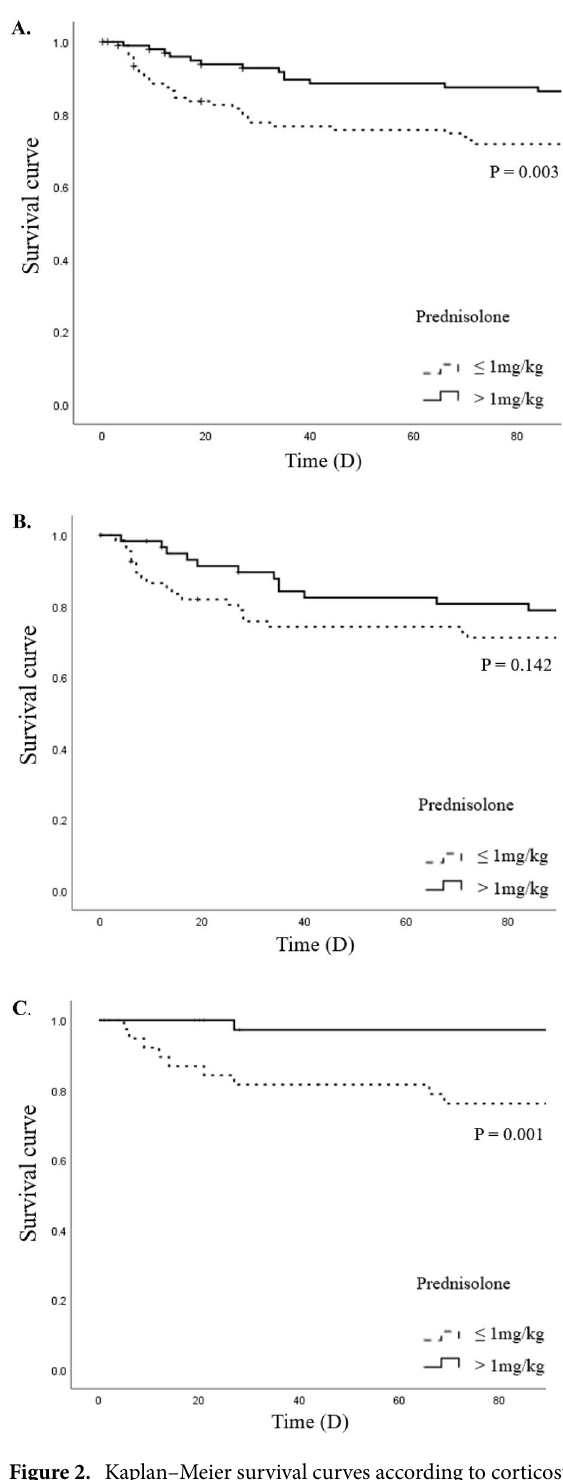
Figure 2. Kaplan–Meier survival curves according to corticosteroid use in ( A ) total patients; ( B) patients with IPF; ( C) patients with non-IPF